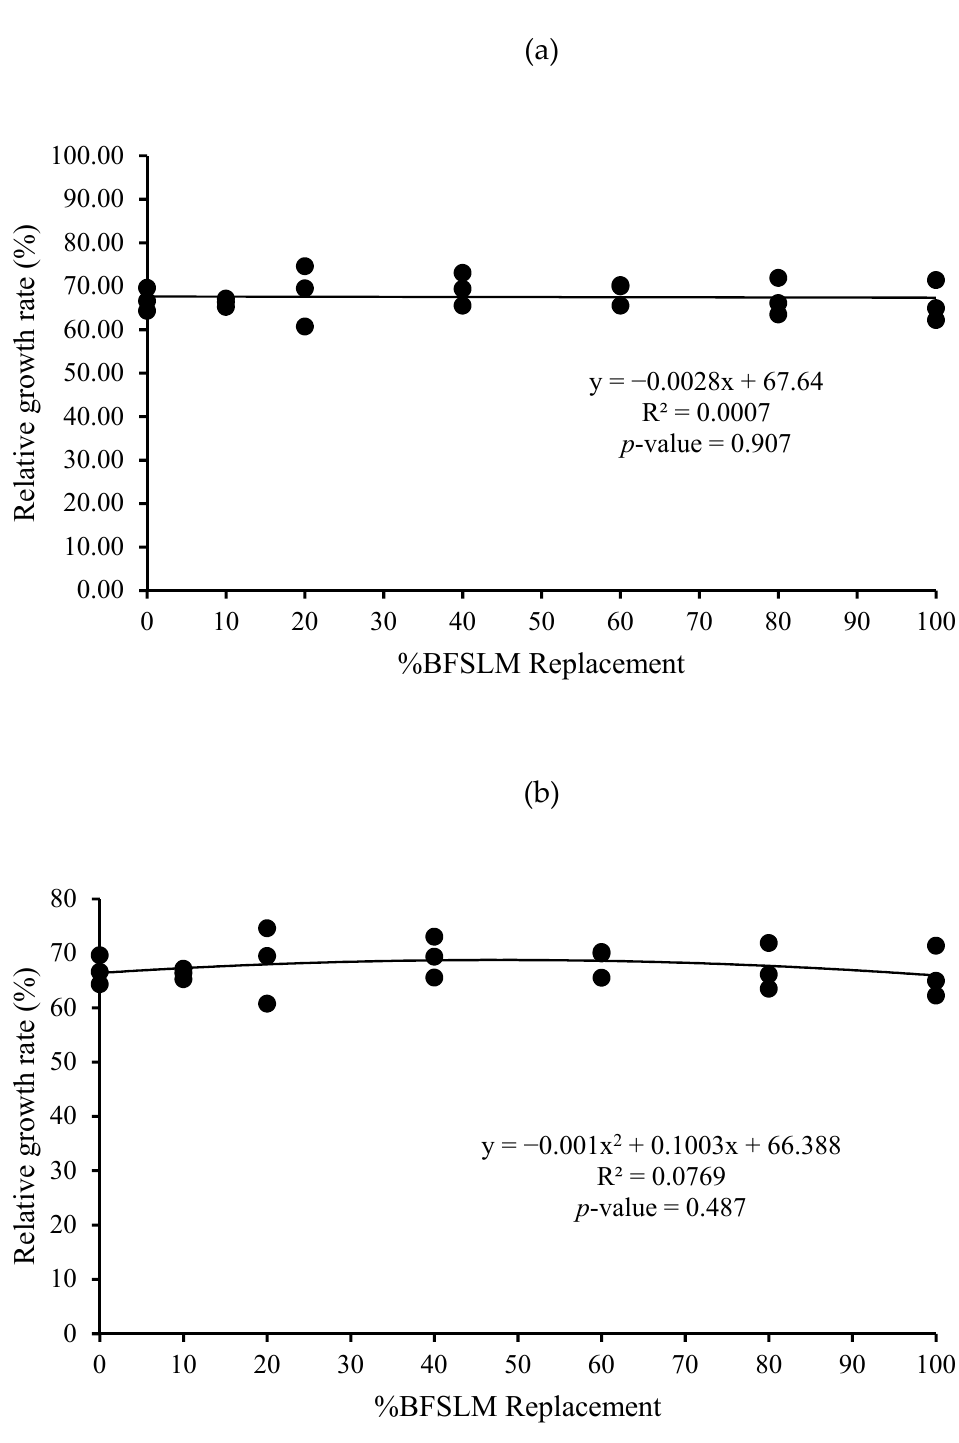
Figure 6. Linear ( a ) and quadratic ( b ) estimate: When X = %BSFLM replacement; Y = Relative growth rate after 12 weeks of feeding with control (0% BSFLM and 100% FM), and FM replaced at 10%, 20%, 40%, 60%, 80%, and 100% of the BSFLM.